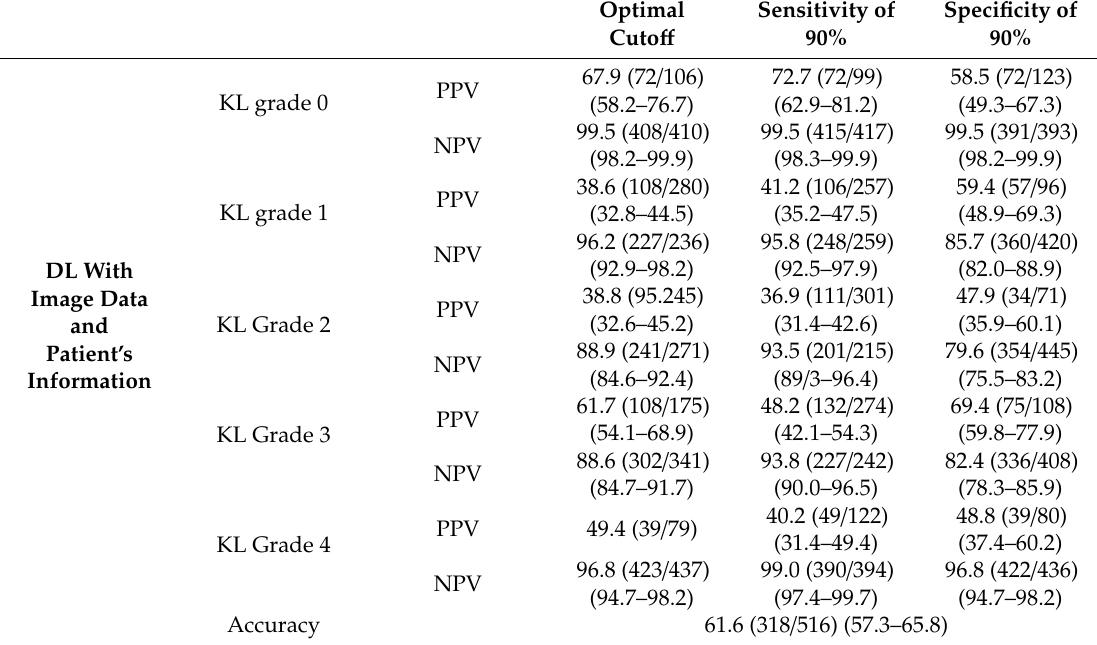
Figure 4. Confusion matrices of predicted and ground truth labels image data and additional patient information. 3.1.4. Gradient-weighted Class Activation Mapping (Grad-CAM) We applied the Grad-CAM technique to locate the most significant areas in the image for classification (Figure5) [20].